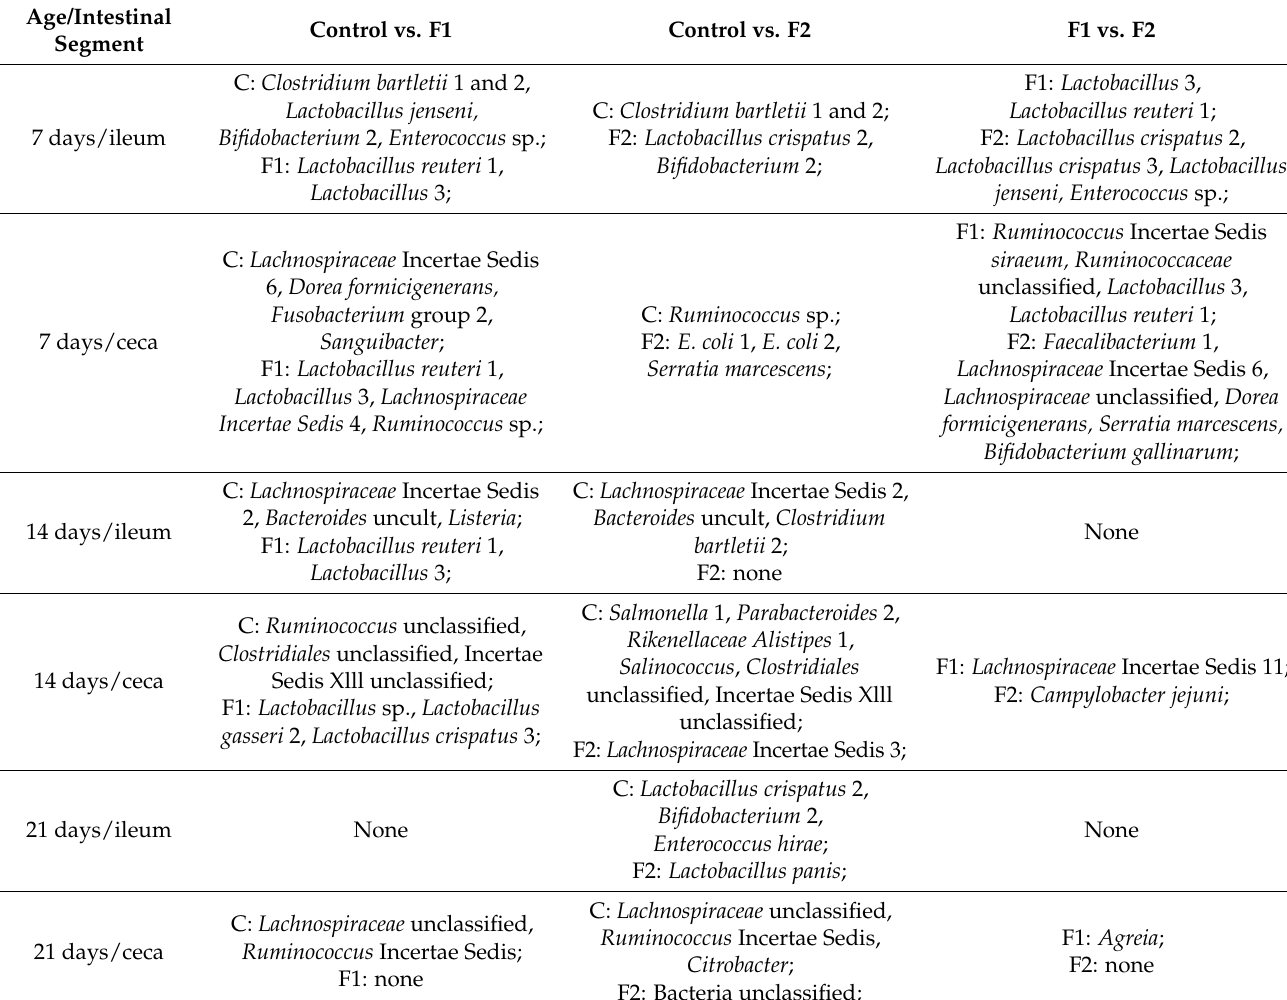
Table 2. Intestinal microbial taxa that are significantly increased with the respective feed at different ages in broiler chickens. The microbial taxa of which the standardized LS means were significantly increased due to the respective feed, as determined by factorial analysis of pairwise comparisons between feed groups at different ages in the ileum or the ceca. Feed groups included standard diet (control), and feed supplemented with glucose oligosaccharide (F1) or long-chain glucomannan (F2), with statistical significance of FDR adjusted p -values set at <